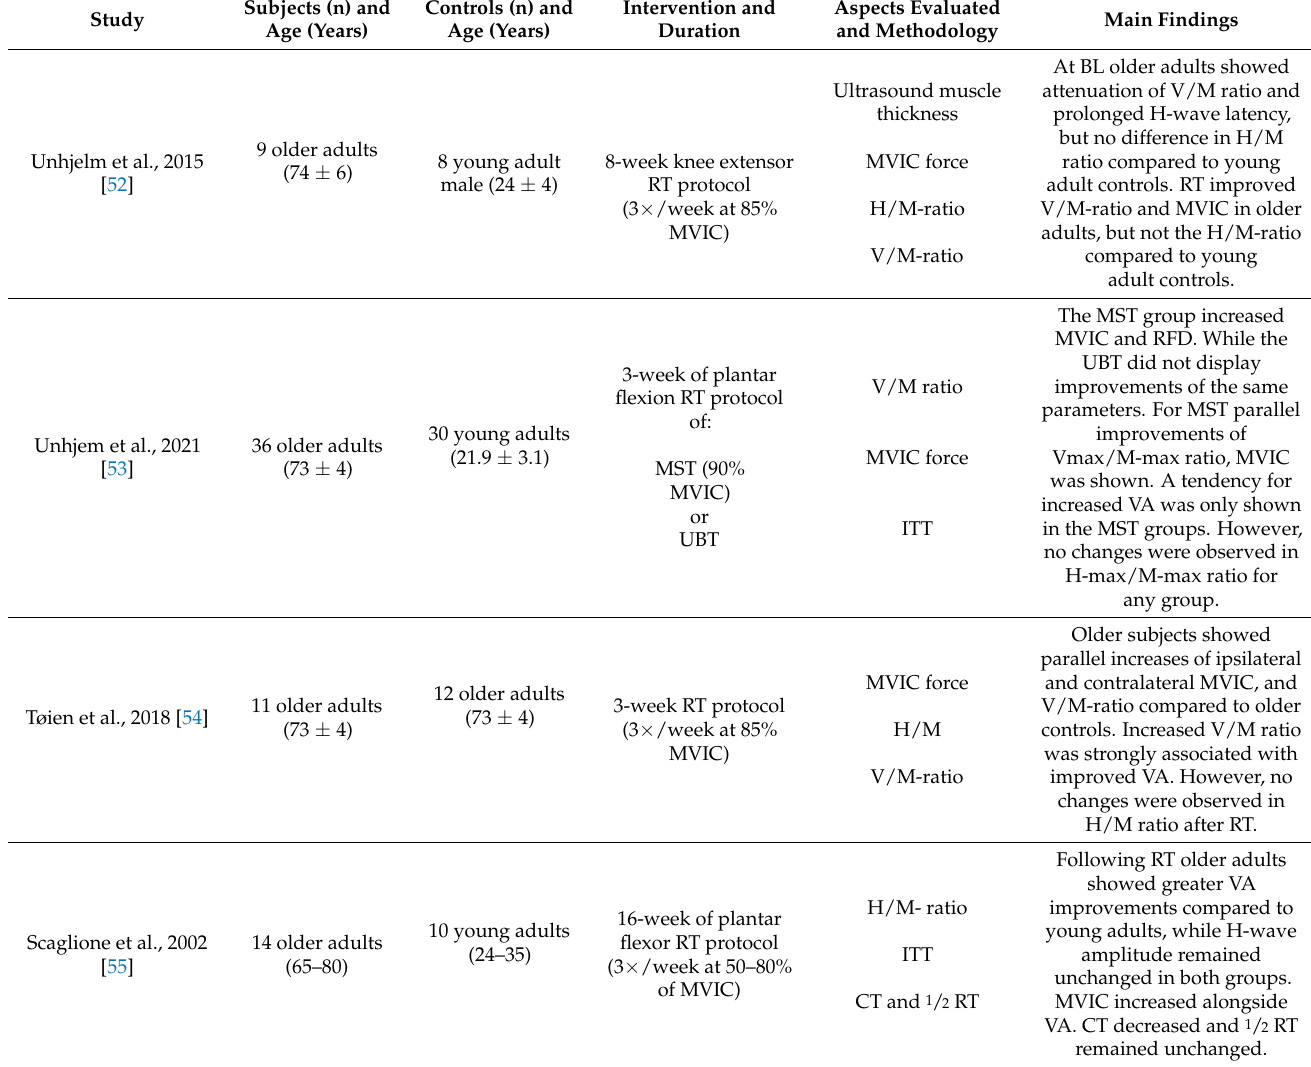
Table 2. Corticospinal-level studies evaluating corticospinal adaptations using TMS and V-wave methodologies following RT in older